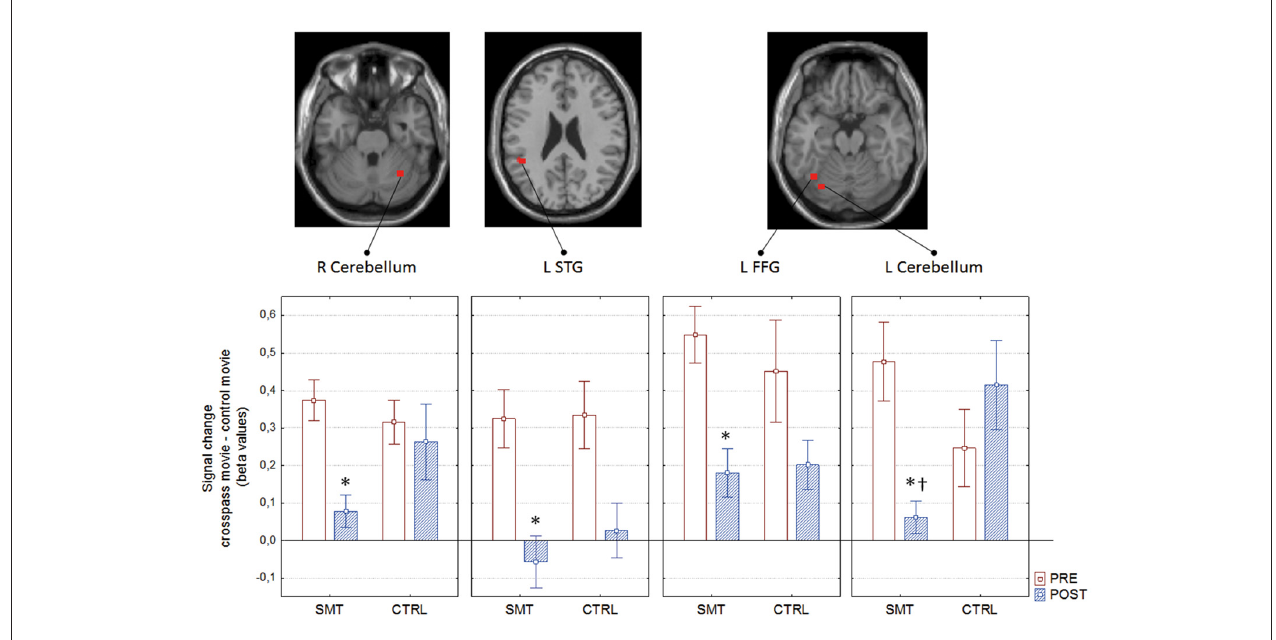
FIGURE 5 | Pre- to post-test blood oxygen level dependent (BOLD) signal change as a function of group, with corresponding neural correlates. ∗ pre- to post-test difference; † between group difference; R, right; L, left; STG, superior temporal gyrus; FFG, fusiform gyrus. Boxes denotes mean and whiskers SEM.